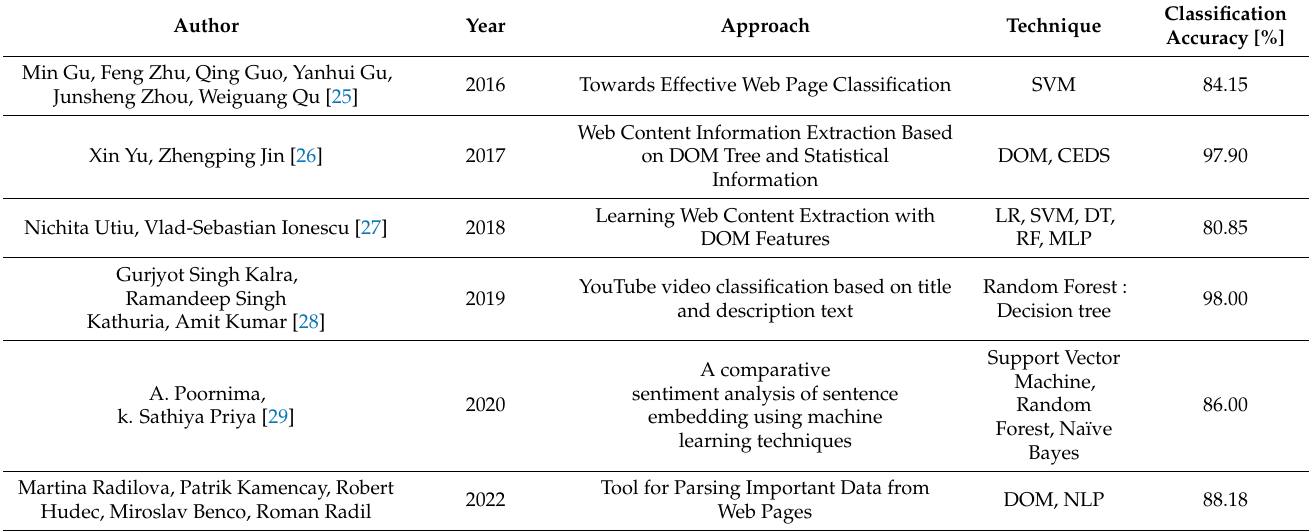
Table 2. The comparison of the web page classification